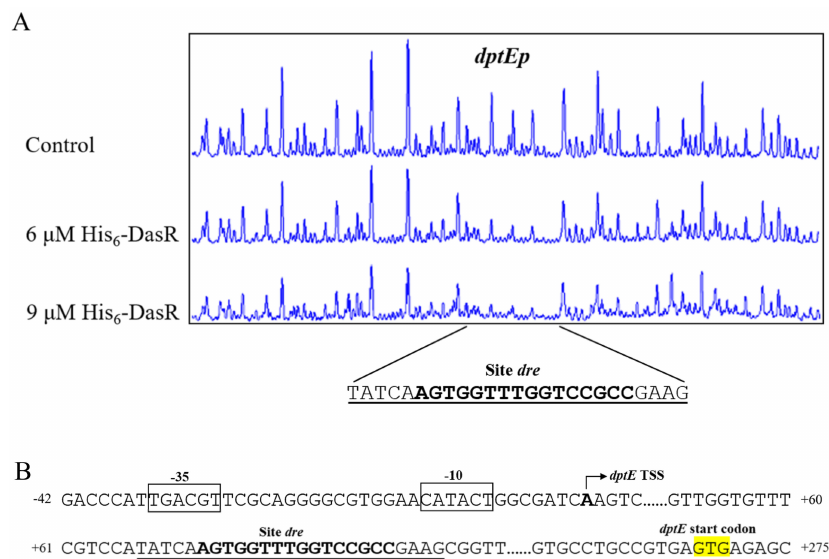
Figure 4. Determination of DasR-binding site on dptEp . ( A ) DNase I footprinting assay of DasR on dptEp . Protection patterns were acquired with increasing His 6 -DasR concentrations. Control: reaction without His 6 -DasR. ( B ) Nucleotide sequences of dptE -promoter region and DasR-binding site. Numbers: distance (nt) from dptE TSS. Bent arrow: dptE TSS. Boxes: putative − 10 and − 35 regions. Yellow highlight: dptE TSC. Solid line: DasR-binding site. Bold font: dre -like